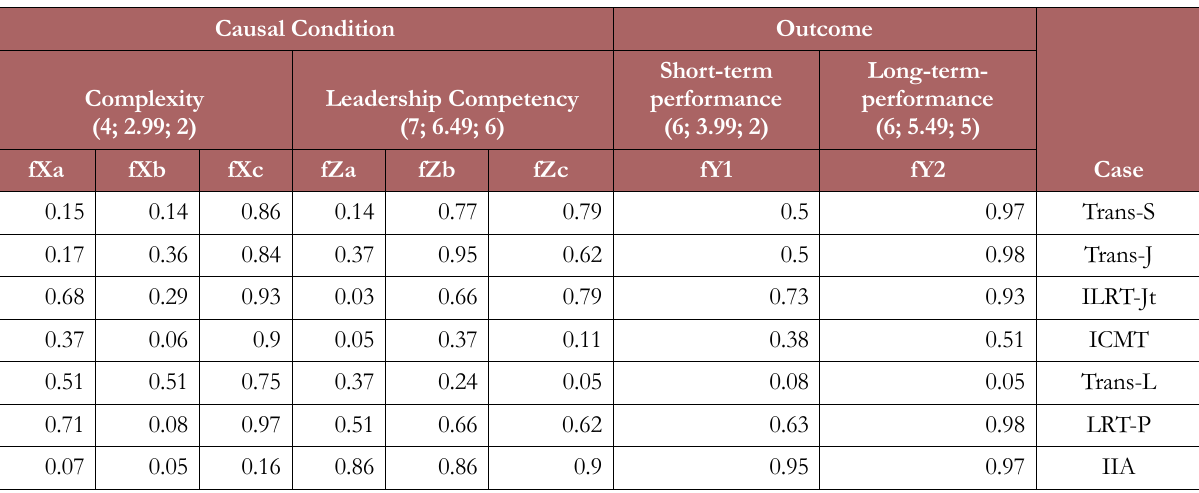
Table 3. The Fuzzy Calibration